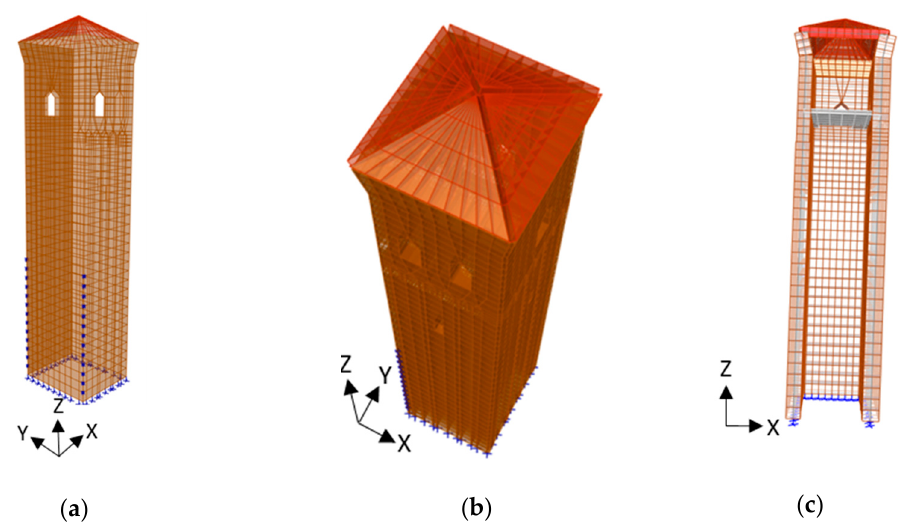
Figure 11. Bell tower finite element model: ( a , b ) 3D views with boundary conditions highlighted in blue; ( c ) front view (XZ plan), in which the tilted geometrical configuration can be appreciated.